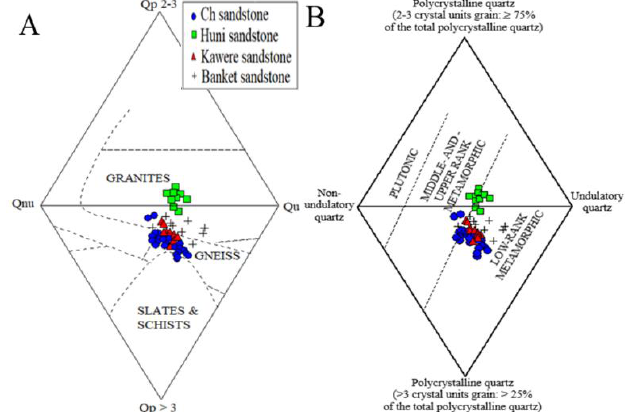
Figure 4: (A) Diamond diagram plot, after Tortosa [26] showing the source of quartz grains (B) Diamond diagram showing the provenance of quartz grains in the sandstones (Basu et al., 1975).